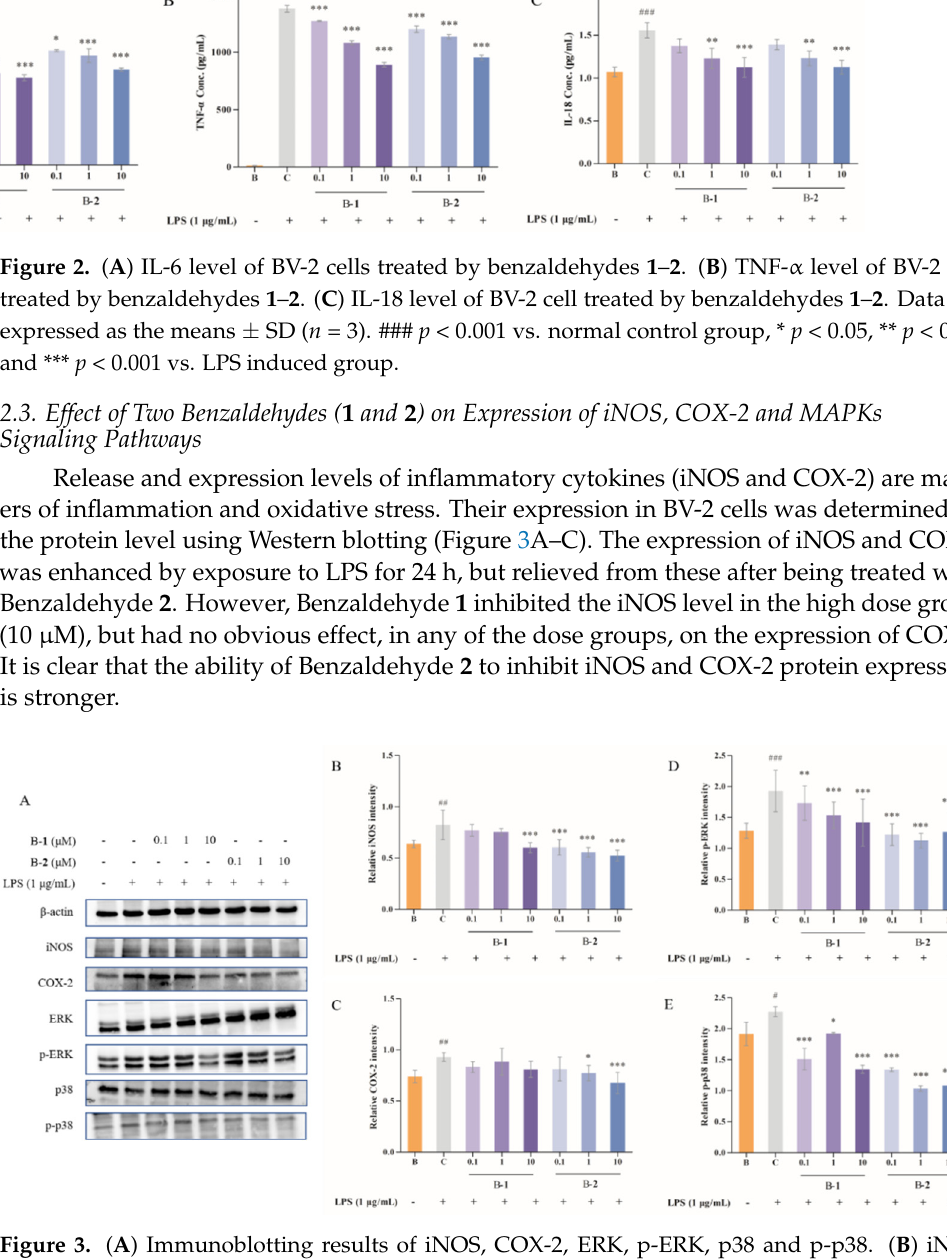
Figure 1. The cell viability of benzaldehydes 1 – 2 in BV–2 cells. Data were expressed as the means ± S.D ( n = 3).